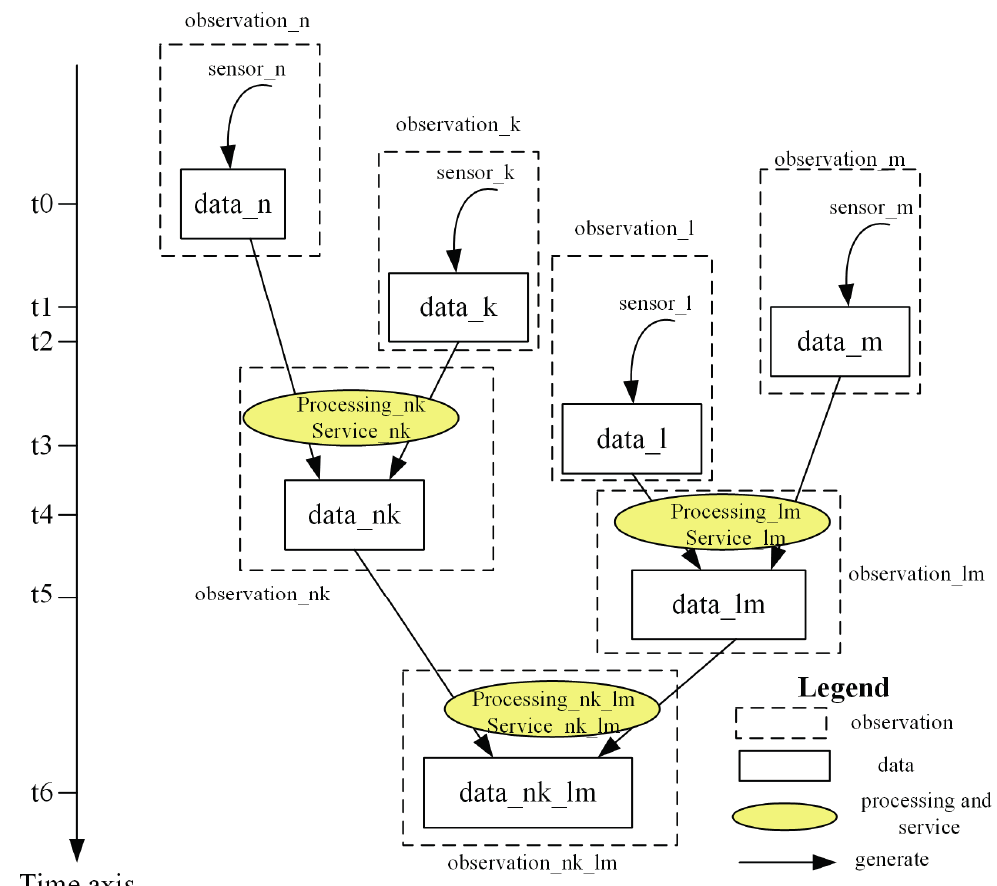
Figure 1. Example observation